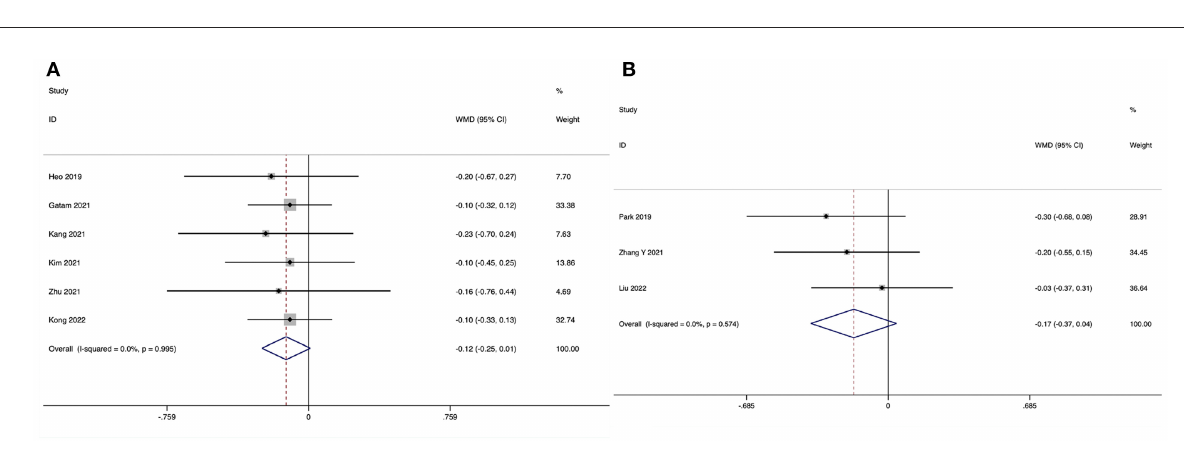
at 1–2 weeks post-operatively between the ULIF group and the MI-TLIF group (WMD, − 0.20; 95% CI − 0.56–0.16, P = 0.281). ULIF vs.